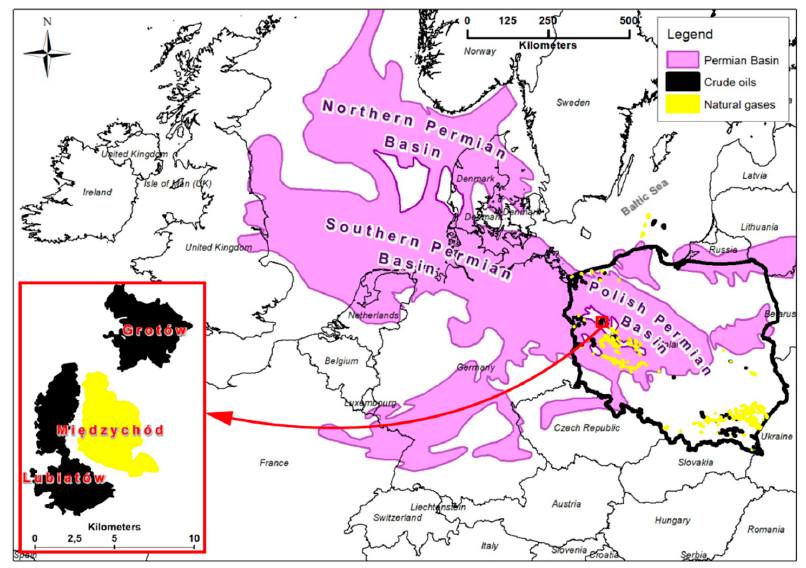
Figure 1. Location of the Zechstein Main Dolomite Basin.